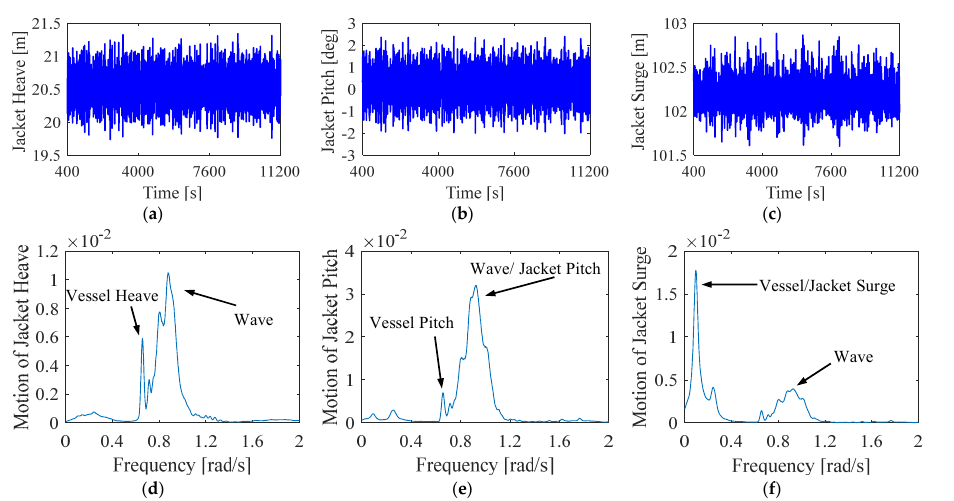
Figure 14. Response time series and PSD of jacket motion ( H s =1.5 m, T p =7 s, Dir=45 deg, JL1-Z3). ( a ) Time series of jacket heave; ( b ) Time series of jacket pitch; ( c ) Time series of jacket surge; ( d ) PSD of jacket heave; ( e ) PSD of jacket pitch; ( f ) PSD of jacket surge.